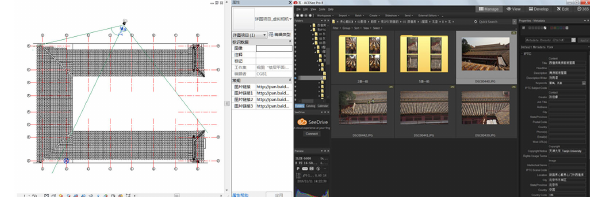
Figure 15 Local e-albums linked with the BIM